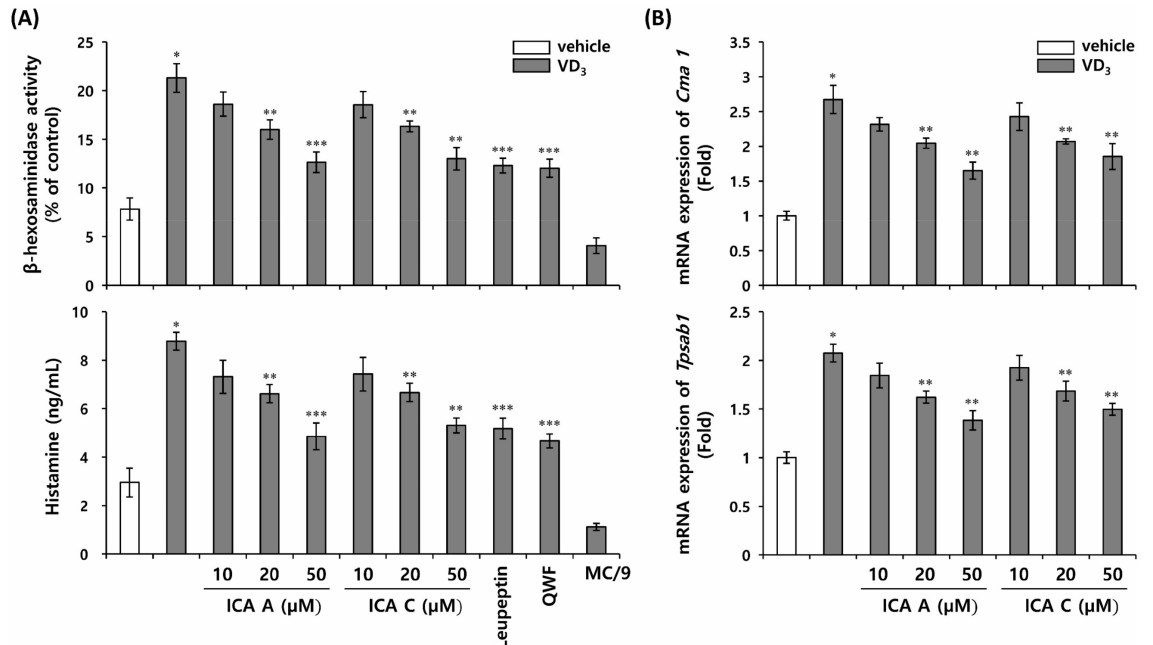
Figure 5. Chlorogenic acid isomers inhibit mast cell activation induced by VD 3 in HEKn/MC/9 co-culture system. HEKn were seeded onto upper insert chambers, and MC/9 cells on the lower chamber of the two-compartment transwell system for 24 h. The upper insert chamber was pretreated with 1, 10, or 50 µ M isochlorogenic acids A and isochlorogenic acid C, and 1 µ M leupeptin for 1 h, and subsequently treated with 200 nM VD 3 . Lower chamber was treated with 10 µ M QWF, an MRGPRX2 antagonist. ( A ) Mast cell degranulation was measured by monitoring the release of β -hexosaminidase and histamine. ( B ) The expression of mast cell protease, chymase ( Cma1 ) and tryptase ( Tpsab1 ) was analyzed via quantitative real-time PCR. The results are expressed as mean ± standard deviation (SD) ( n = 3). * p < 0.01 vs. vehicle control; ** p < 0.05 vs. VD 3 -treated control; *** p < 0.01 vs. VD 3 -treated control. ICA A, isochlorogenic acid A; ICA C, isochlorogenic acid